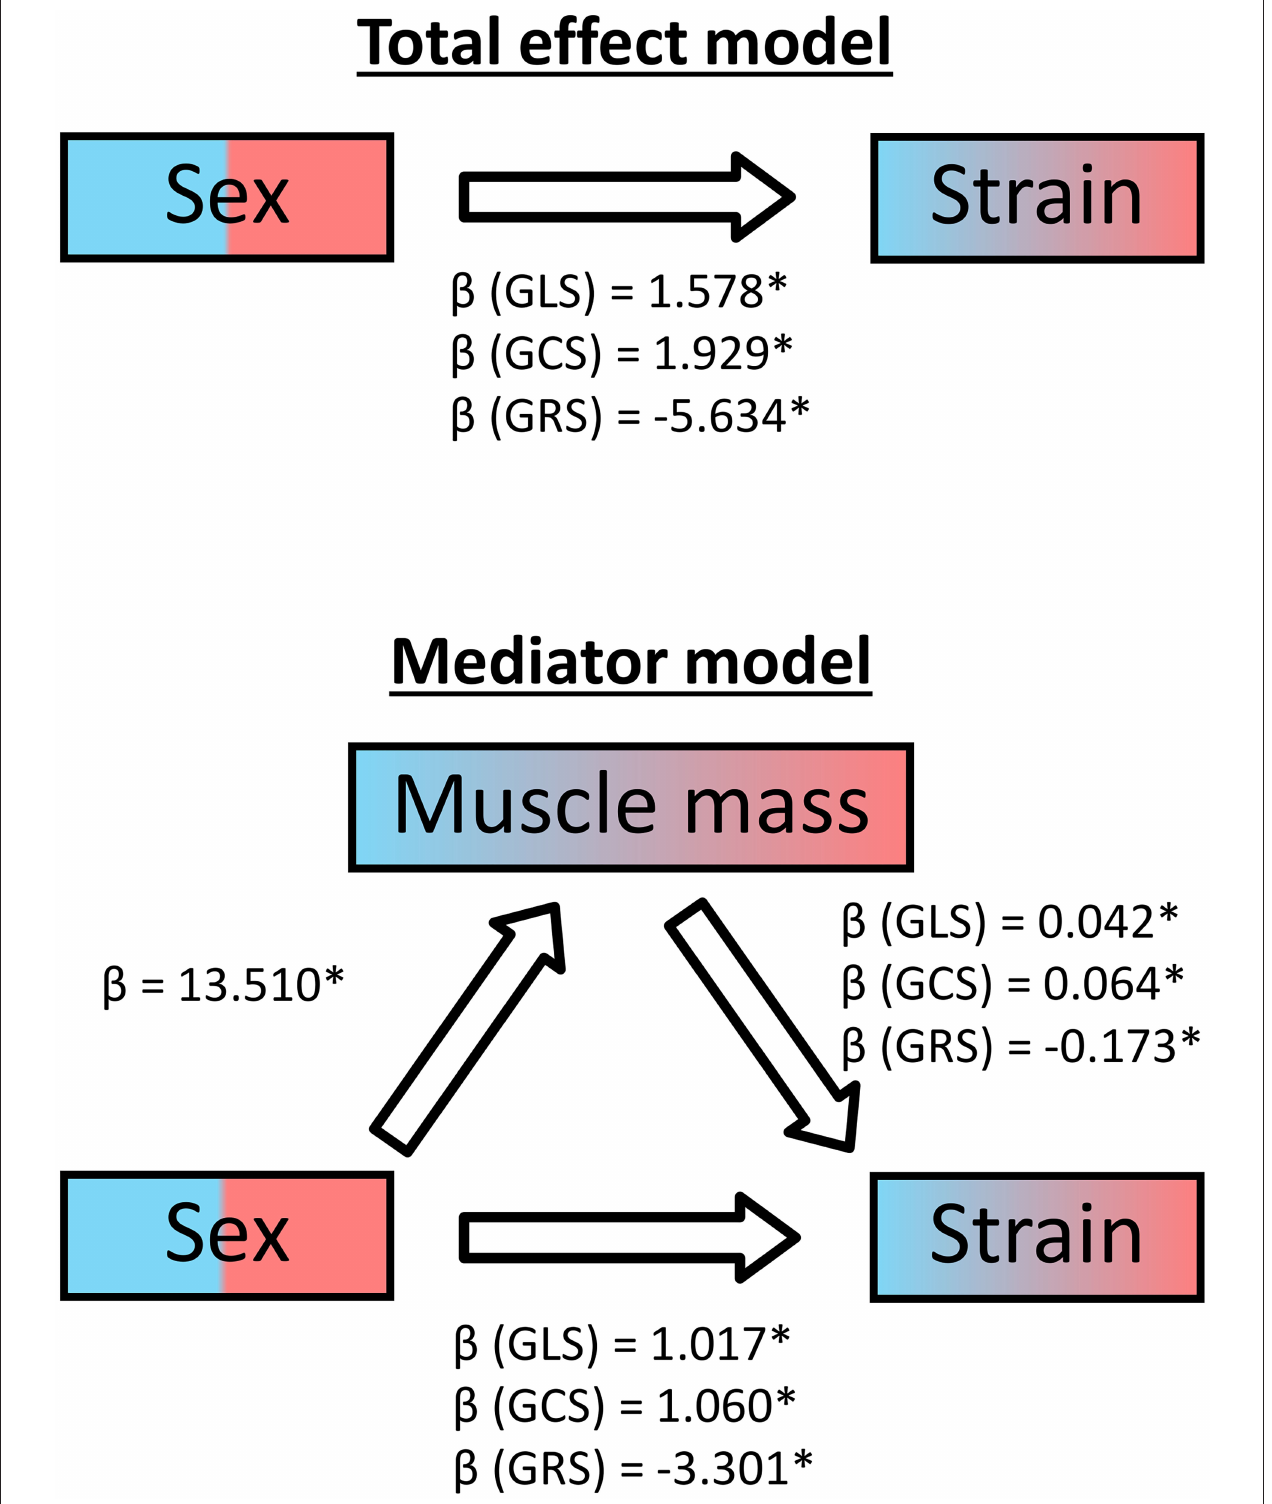
FIGURE 6 | Mediator analysis of cardiac muscle mass for healthy subjects. GLS, global longitudinal strain; GCS, global circumferential strain; GRS, global radial strain; β , regression coefficient; *statistically significant with p < 0.05.